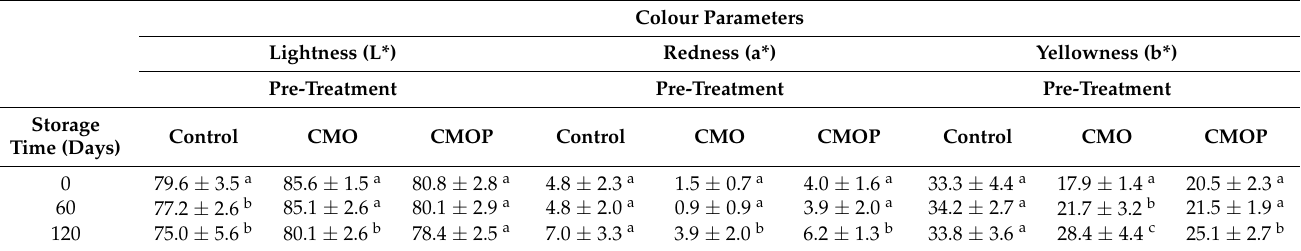
Table 3. Impact of storage time on the colour parameters of dried apple slices 1 . Colour